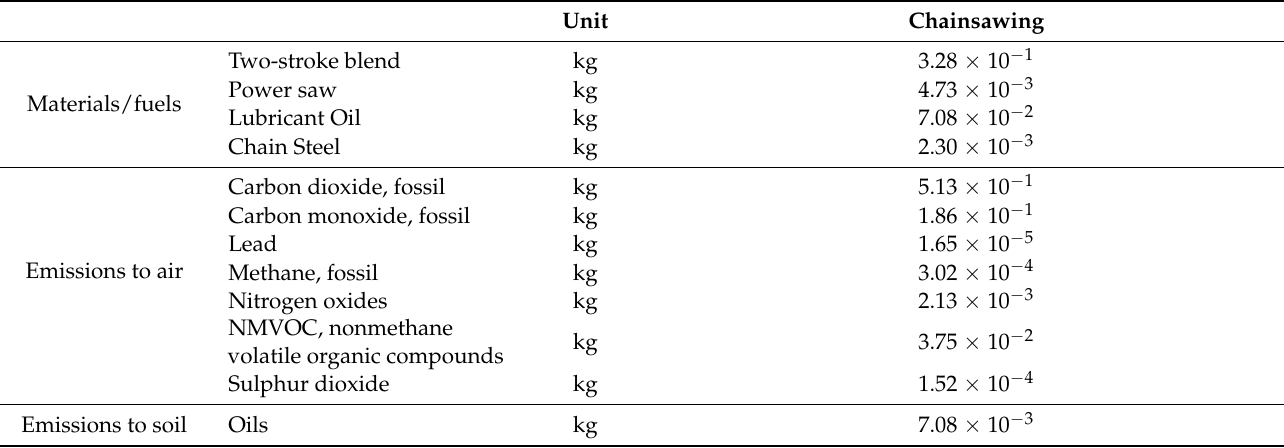
Table 4. Inventory per “1 m 3 of wood